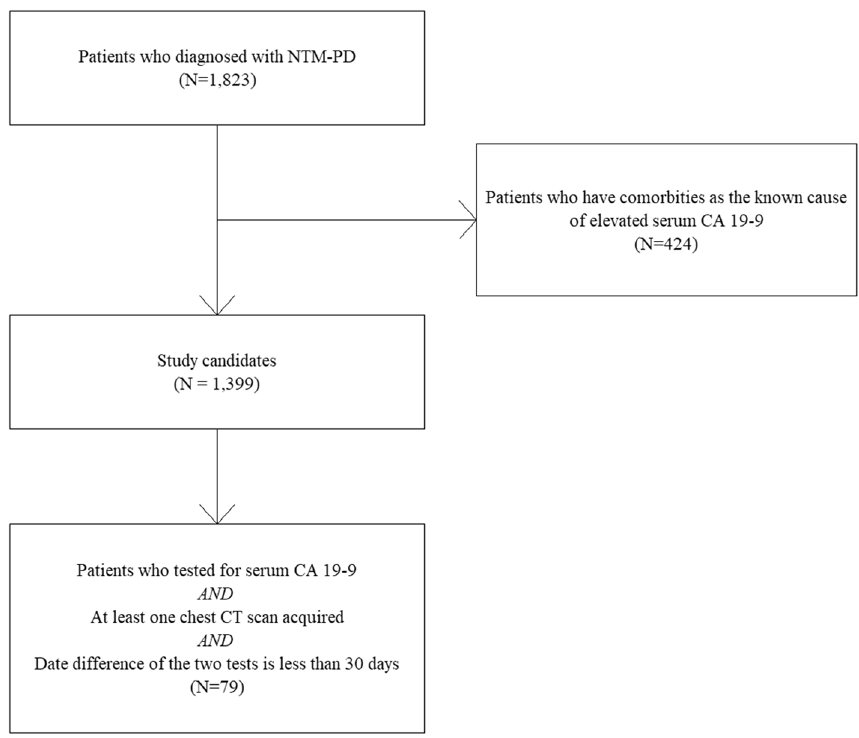
Figure 1. Selection process of the study population. NTM-PD nontuberculous mycobacterial pulmonary disease, CA carbohydrate antigen, CT computed